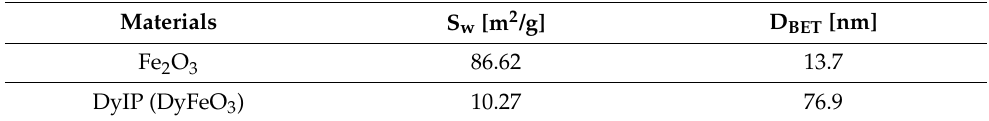
Table 1. Specific surface area and particle sizes of the